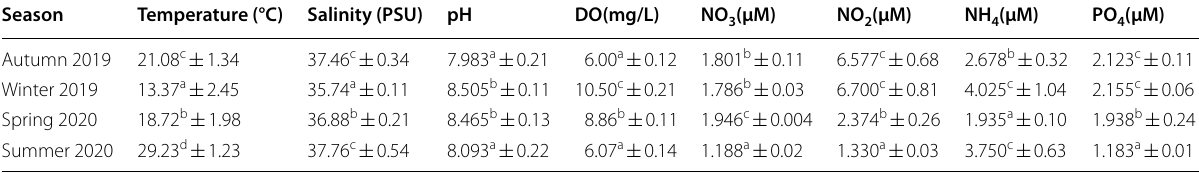
a Values are means of three replicates parameter